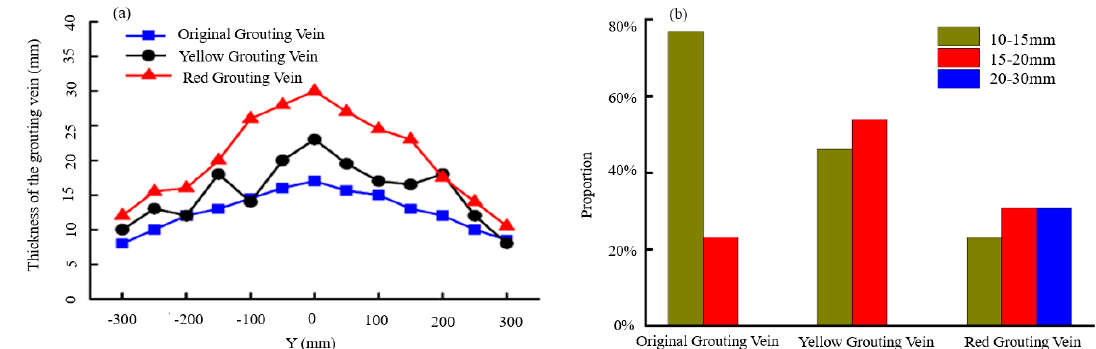
Figure 7. Thickness distribution of the grouting veins in A (200 mm) section: ( a ) thickness distribution of the grouting veins along the direction of grout migration; and ( b ) thickness distribution proportions of the different grouting veins.